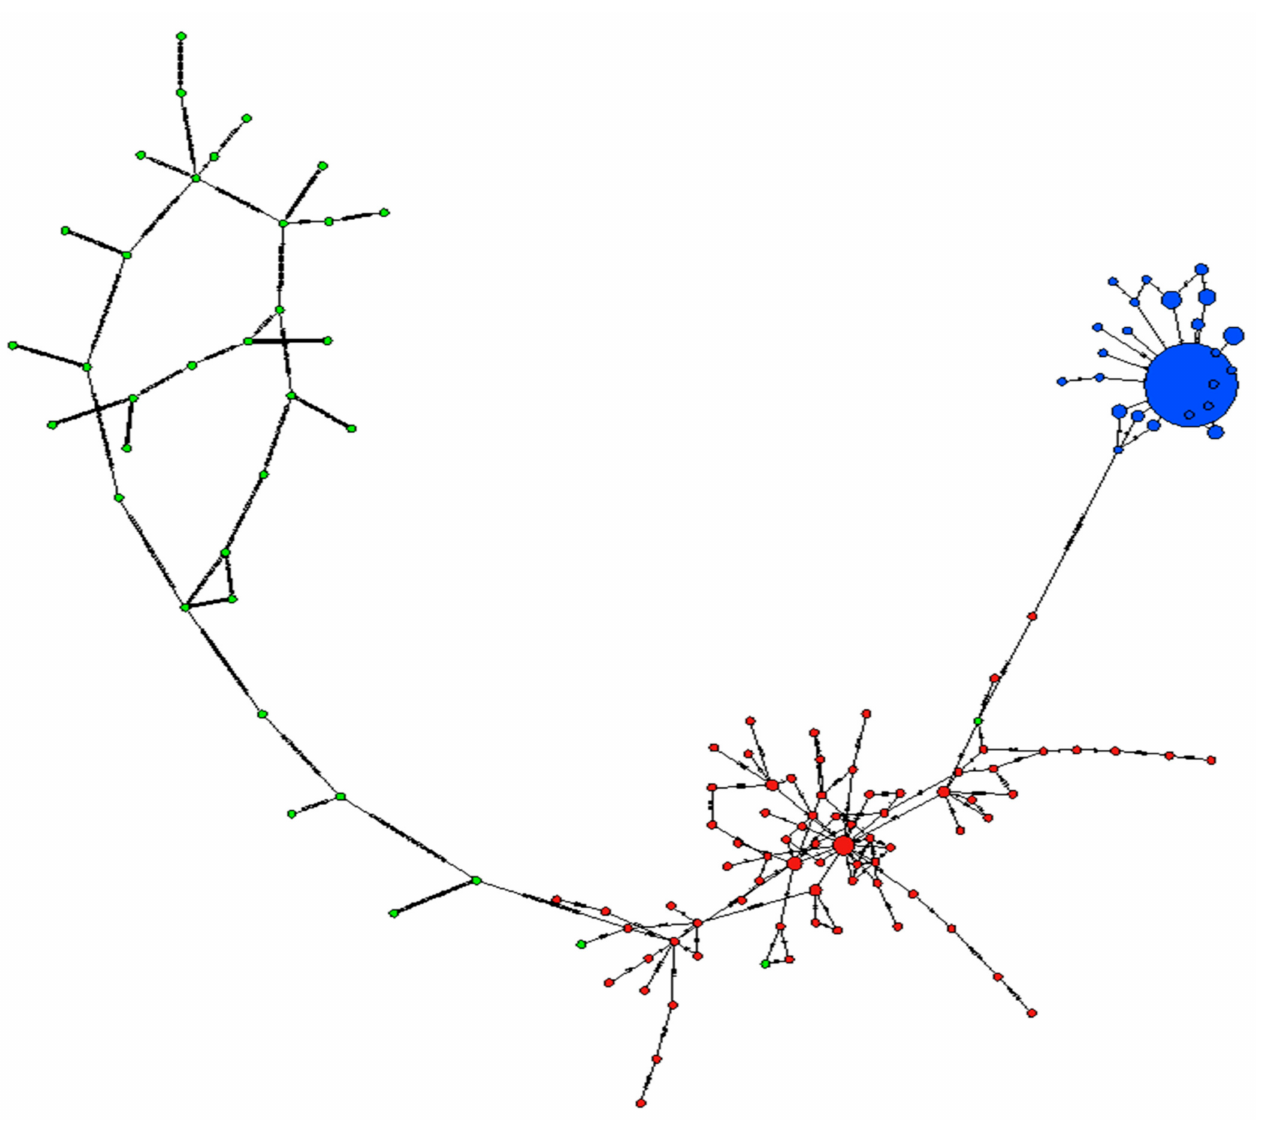
Figure 5. Minimum spanning networks using the three groups: TC (blue), R1-3-5 (red), and R2-4 (green). Each circle represents a haplotype; the circle sizes correspond to abundances. Bars indicate the number of mutations between